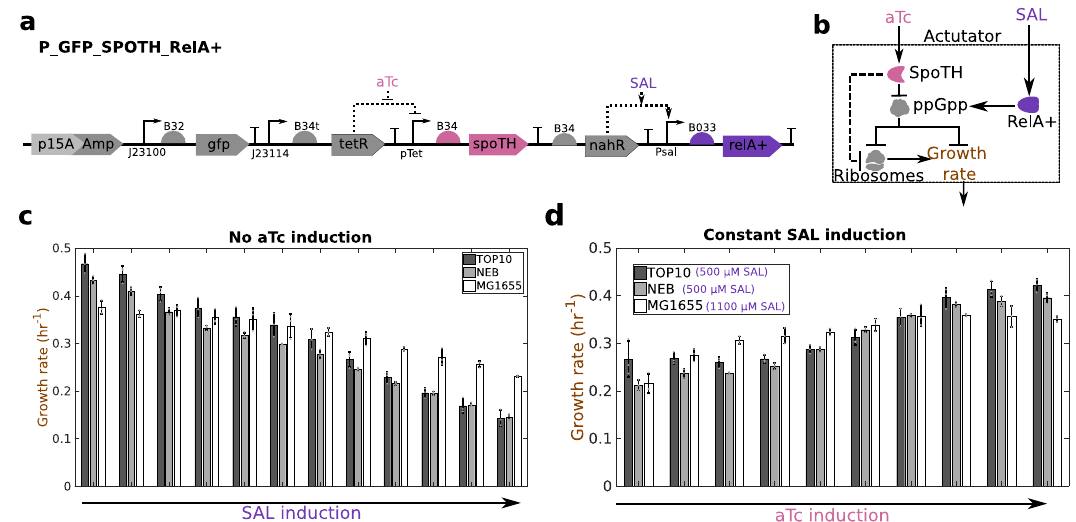
Fig. 4 | RelA+ expression allows to transport the ribosome controller to a desiredbacterialstrain.a P_GFP_SpoTH_RelA+constructexpressesSpoTHviathe inducible pTet promoter and RelA+ via the inducible Psal promoter. Plasmid description, plasmid map, and essential DNA sequences are provided in Supple- mentary Information section Plasmid maps and DNA sequences . b Circuit diagram depicting the effect of RelA+ induction and SpoTH induction on ribosomes and growth rate. Addition of SAL increases RelA+ concentration and thus upregulates ppGpp concentration 64 . Addition of aTc increases SpoTH concentration, which lowers ppGpp concentration and consequently upregulates both free ribosome concentration and growth rate 35 . The dashed fl at headed arrow from SpoTH